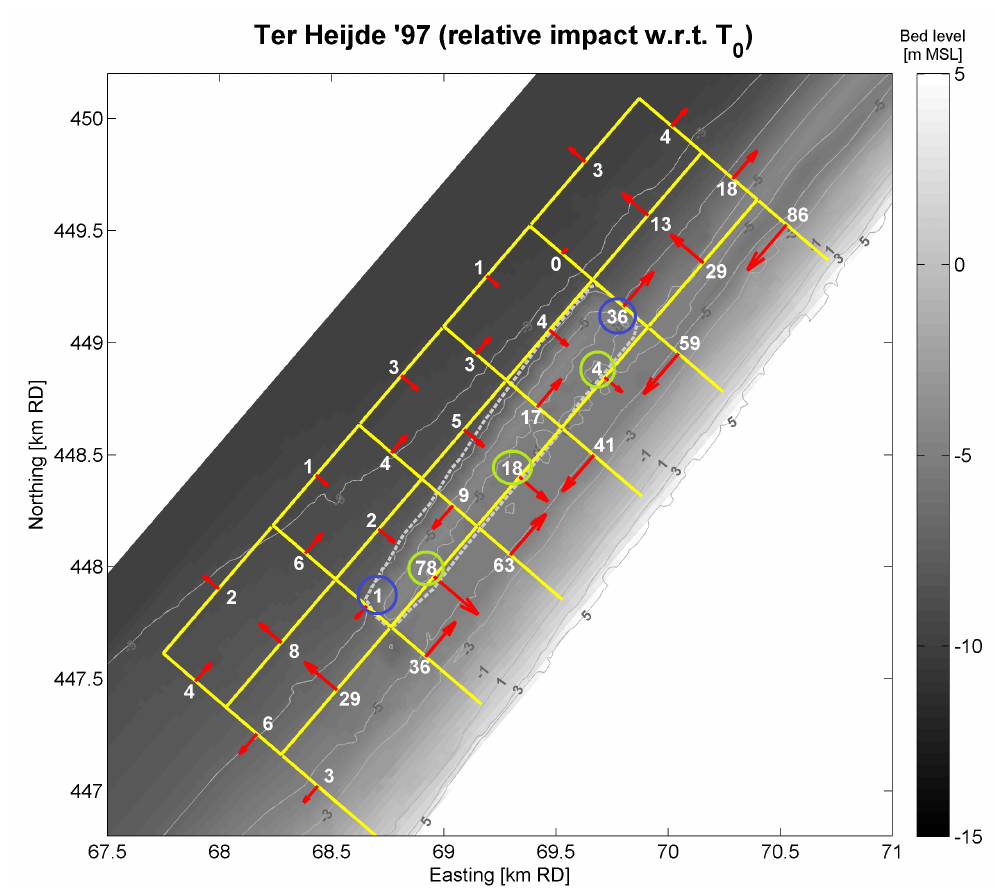
Figure 13. Computed year-averaged transport rates (in 10 3 m 3 /yr w.r.t. pre-nourishment situation) at Ter Heijde’97 shoreface nourishment based on XBeach simulations. The dashed gray line indicates the initial nourishment region. Cross-shore losses from the nourishment are indicated with the green circles, while the alongshore losses are marked with blue